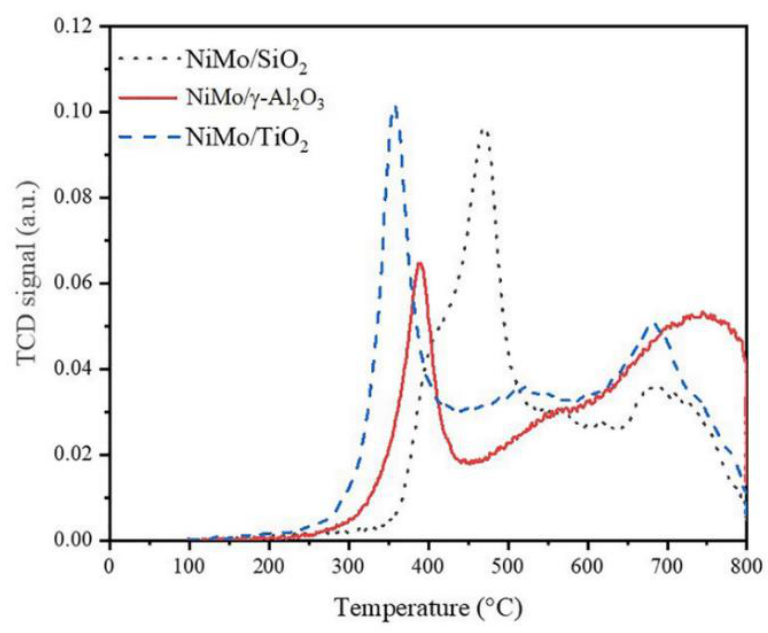
Figure 3. H 2 -temperature-programmed reduction profiles of the calcined NiMo/ γ -Al 2 O 3 , NiMo/SiO 2 , and NiMo/TiO 2 catalysts.